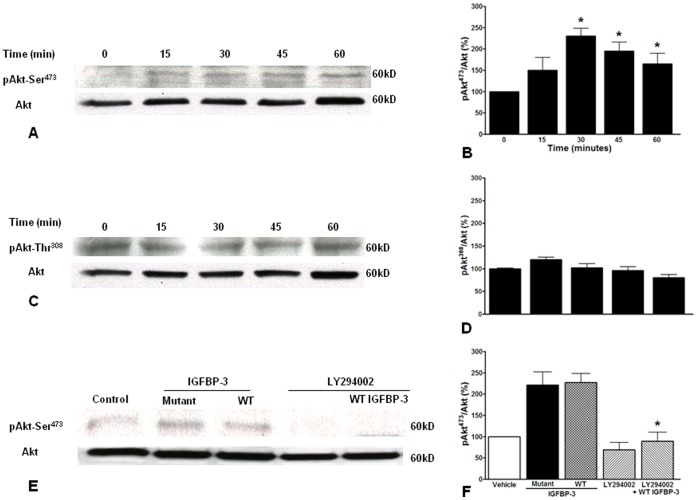
IGFBP-3 causes Akt phosphorylation at Ser473.
A. Representative western blot depicting the time-course of Akt phosphorylation at Ser473 residue by 100 ng/ml IGFBP-3 and the bar graph (B) showing the pAkt473/Akt following IGFBP-3 stimulation (*P<0.01, n = 3). C. Representative western blot depicting the time-course of Akt phosphorylation at Thr308 residue by 100 ng/ml IGFBP-3 and the bar graph (D) showing the pAkt308/Akt following IGFBP-3 stimulation (n = 3). E. Representative western blot depicting the Akt-Ser473 phosphorylation by wild type (WT) and IGF-1 non-binding mutant of IGFBP-3 and the effects of PI3K inhibitor LY294002 (30 µM). F. WT and mutant IGFBP-3 phosphorylated Akt-Ser473 to similar extents and the phosphorylation by IGFBP-3 was blocked by LY294002 (*P<0.001, n = 3).